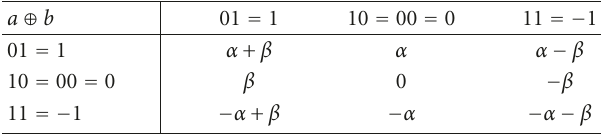
Table 2: Definition of the operation ⊕ for k =